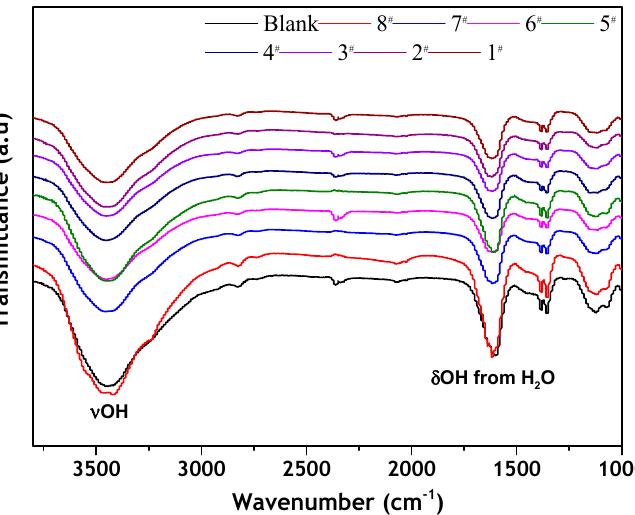
Figure 2. FTIR spectra of graphite before and after modification with different dosages of CTAC.